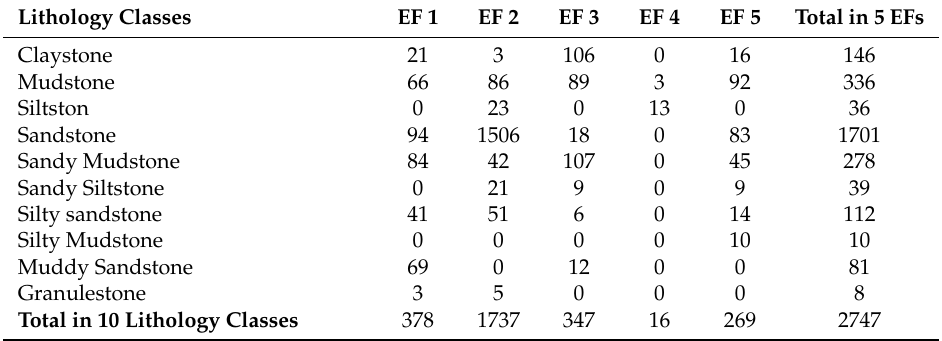
Figure 4. Graphical representation of different lithologies forming the electrofacies. Table 5. Number of samples in each electrofacies according to the lithology classes.